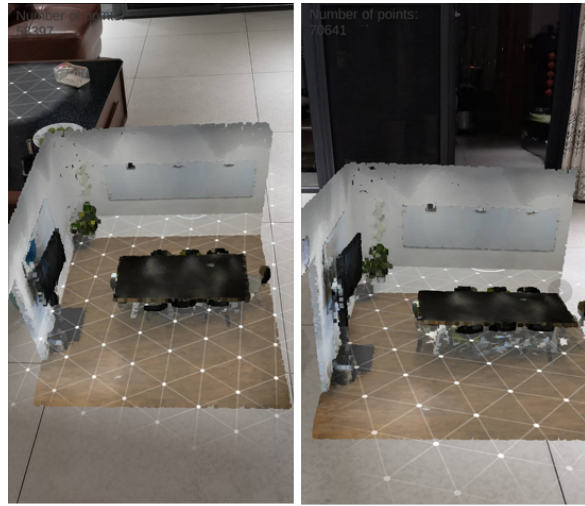
Figure 5. Result with 58,397 points(left) and 70641